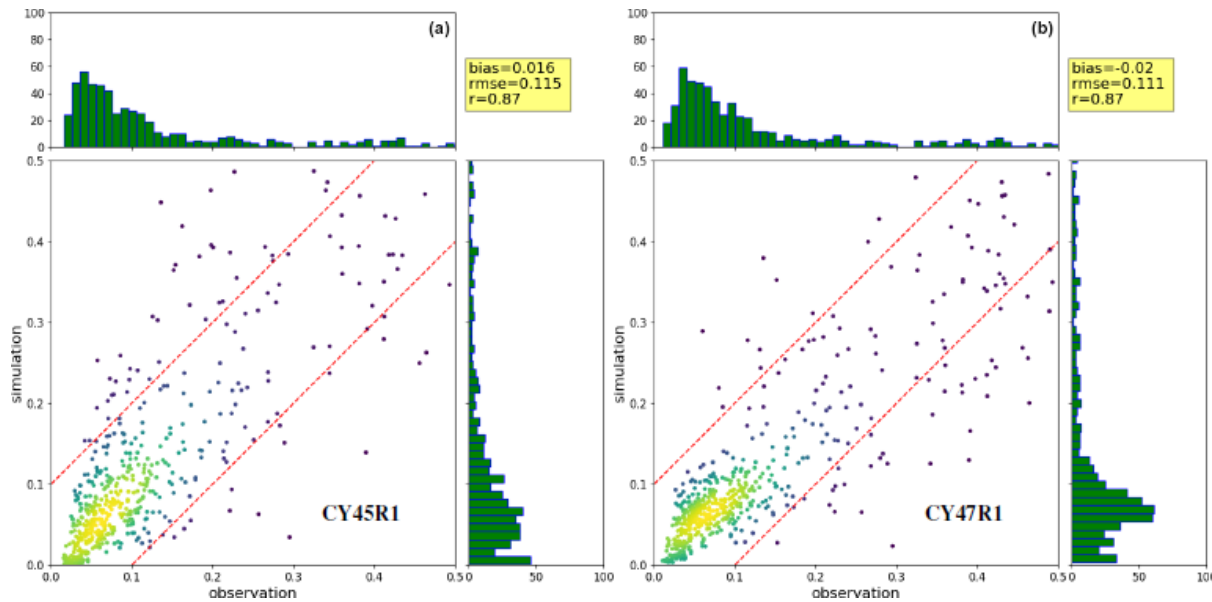
Figure 12. Density scatterplot (for 2017) of AOD at 550nm simulated by IFS-AER ( a cycle 45R1, b cycle 47R1) and observed by the MAN network.